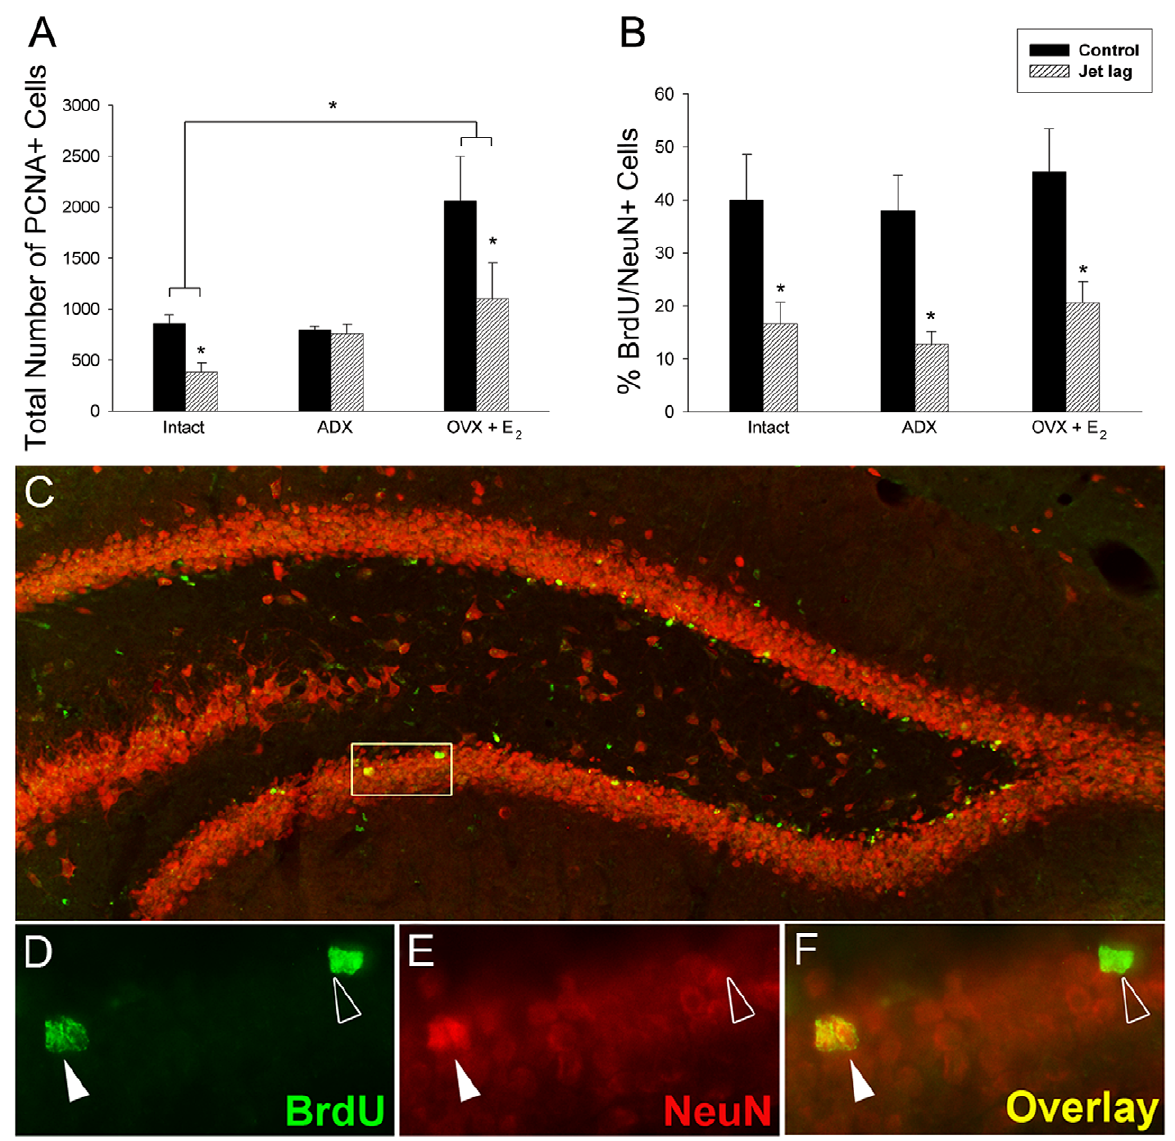
Figure 1. Jet lag adversely impacts PCNA immunostaining and neurogenesis in the dentate gyrus. (A) The number of PCNA-labeled cells in the granule cell layer was affected by the hormonal condition of the animal ( F 2,20 =4.014, P= 0.03), with ovariectomy and estradiol replacement significantly increasing the number of labeled cells as compared to intact hamsters ( P= 0.04). Jet lag resulted in a significant decrease in the number of PCNA-labeled cells in both intact and OVX + E 2 hamsters ( P= 0.007 and P= 0.05, respectively by planned comparisons) while the number of PCNA- labeled cells in adrenalectomized animals was not affected by chronic temporal disruption ( P= 0.80). (B) Neurogenesis was decreased by jet lag ( F 1,21 =20.147, P , 0.001), but there was no significant effect of hormone condition ( F 1,21 =0.228, P= 0.80) and no interaction ( F 2,21 =0.231, P= 0.80). Chronic jet lag resulted in a decrease in neurogenesis by . 50% in intact, ADX, and OVX + E 2 hamsters ( P= 0.01, P= 0.007, and P= 0.05, respectively; * P , 0.05, n=4/5 animals/group). (C–F) Sections were processed for double-label BrdU (green) and NeuN (red), a marker for mature neurons, and quantified at 400 6 . (C) Photomicrograph of the dorsal and ventral blades of the dentate gyrus. Cells were considered double-labeled when BrdU (D) and NeuN (E) co-localized in the same focal plane (F; yellow).